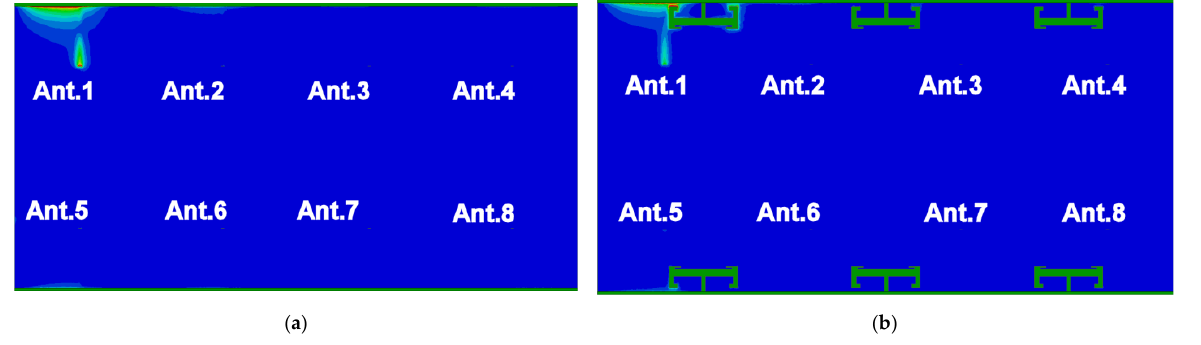
( b ) Figure 4. Simulated S-parameter ( a ) with no decoupling element ( b ) with the decoupling element. 3. Results and Discussions The proposed eight-element array antenna simulation results, such as parametric analysis, envelope correlation coefficient (ECC), S-parameters, overall efficiency, antenna gain, and radiation pattern, are presented in this section. 3.1. Parametric Analysis, S-parameters, Gain, and Efficiency Variations of some design parameters were investigated in this study. Figure 5a – e shows the plots of the scattering parameters as a dependent variable on L , t , d , g , and I, respectively. Sweeps were performed to validate the impact of the aforementioned factors on system performance. From Figure 5a, it is clear that with the initial parameter value of 15 mm, the first resonance is at 3.53 GHz, so also all other values remain at that frequency. The only effect here is that the magnitude of the resonance increases with an increase in the L value.